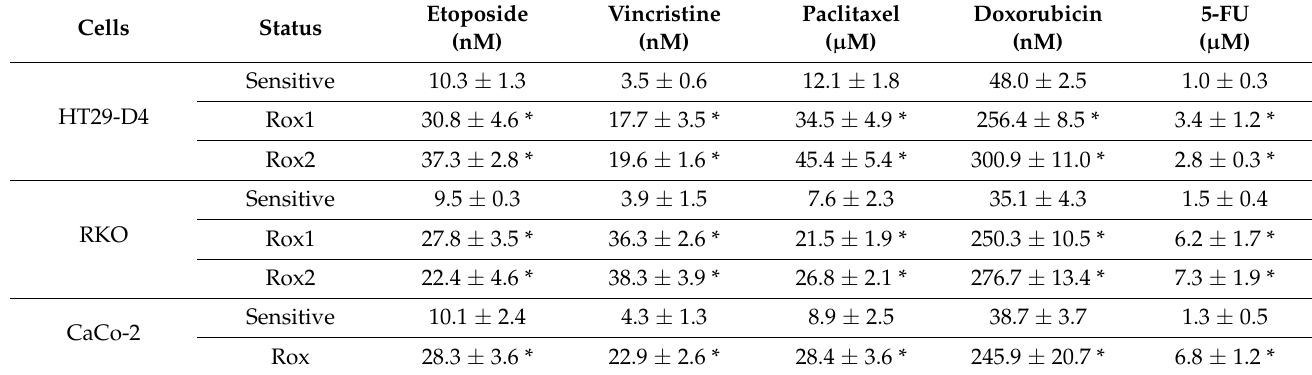
Table 1. Summary of the IC 50 values calculated for the HT29-D4, RKO, and CaCo-2 cell types after 72-hour treatments with etoposide, vincristine, paclitaxel, doxorubicin, and 5-FU. The results are expressed as means ± standard deviations. * is indicative of p <